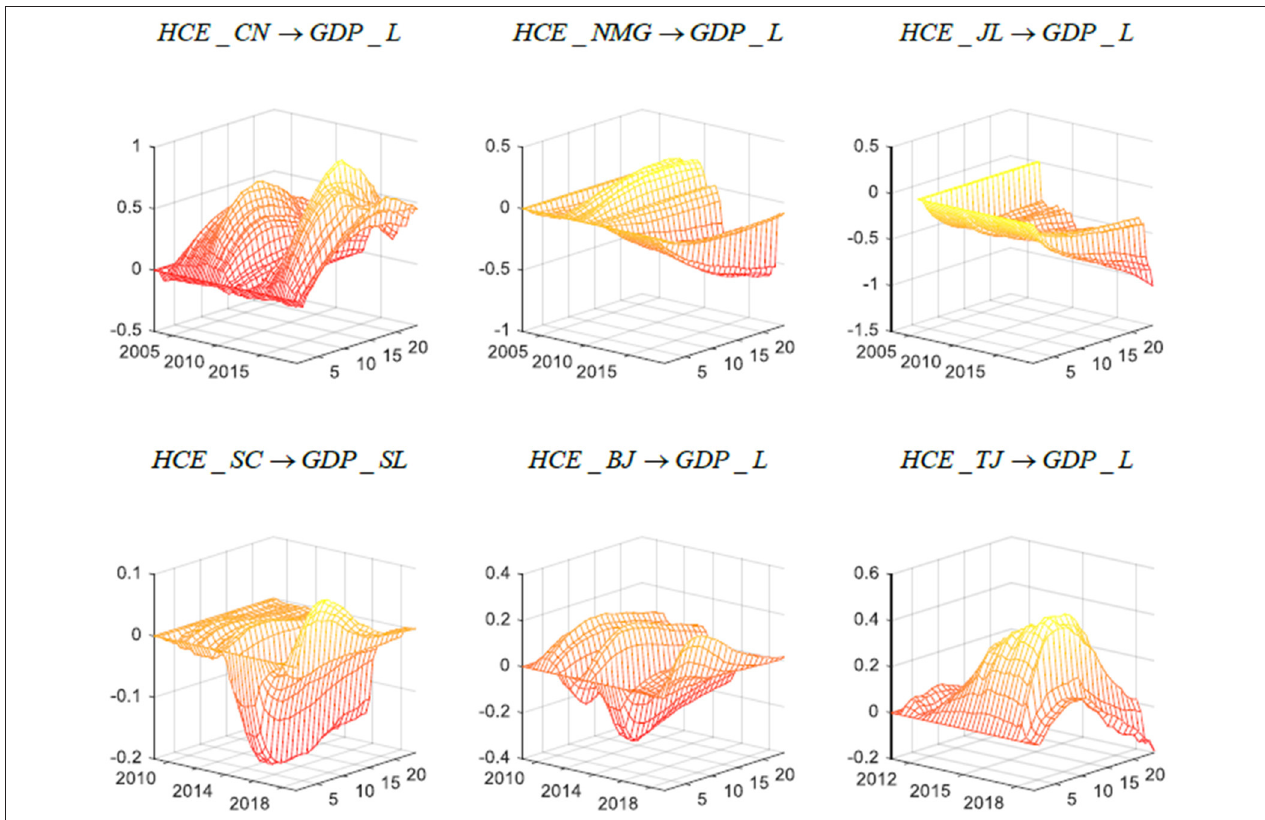
FIGURE 2 | Three-dimensional impulse response of China’s long-term economic growth in different regions. Each subfigure with the title of “ X → Y ” demonstrates the response of variable Y to an orthogonalized positive shock to variable X. In other words, X is an impulse variable, and Y is a response variable. One period in the figure denotes one